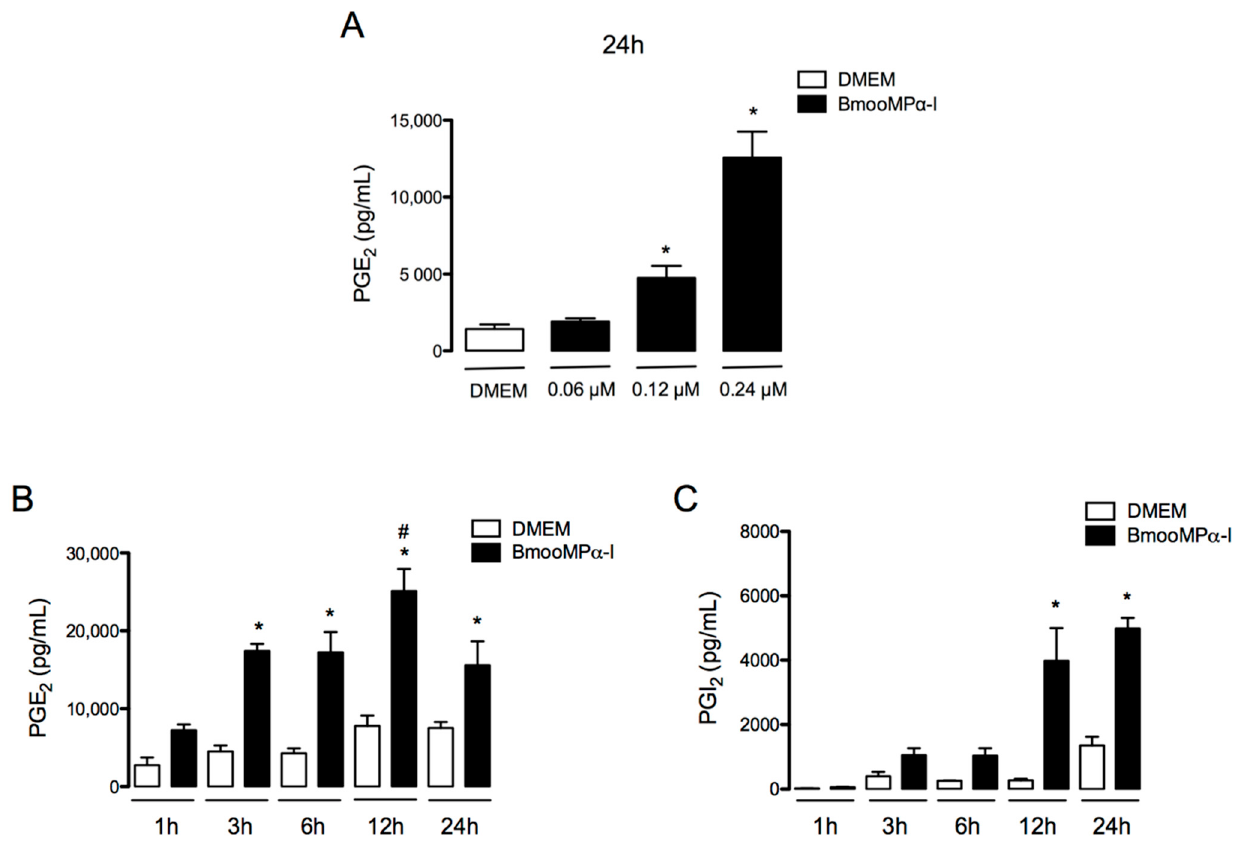
Figure 1. BmooMP α -I induces production of PGE 2 and PGI 2 by preadipocytes: ( A ) effects of selected concentrations of BmooMP α -I in the release of PGE 2 at 24 h; ( B ) time-course of BmooMP α -I-induced release of PGE 2 ; ( C ) time-course of BmooMP α -I-induced release of PGI 2 . Preadipocytes were incubated with BmooMP α− I (0.06, 0.12, or 0.24 μ M) or DMEM (control) for 1, 3, 6, 12, or 24 h. Concentrations of PGE 2 and PGI 2 in culture supernatants were determined by EIA. Results are expressed as means ± SEM of 3 experiments. Note: * p < 0.05 vs. control; # p < 0.05 vs. BmooMP α− I (two-way ANOVA and Bonferroni post-test).